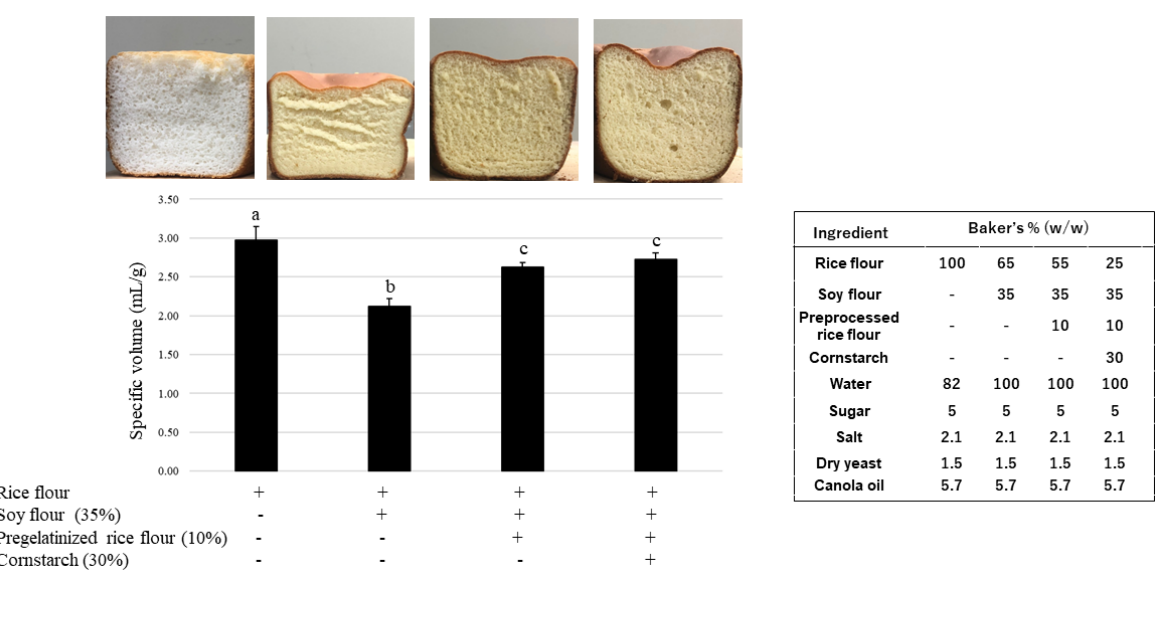
Figure 4. ( A ) Improvement in bread specific volume via addition of pregelatinized rice flour and cornstarch; ( B ) Recipes for soy rice bread with preprocessed rice flour and cornstarch. Data are shown as mean ± SD. Different letters indicate p < 0.05 between groups.